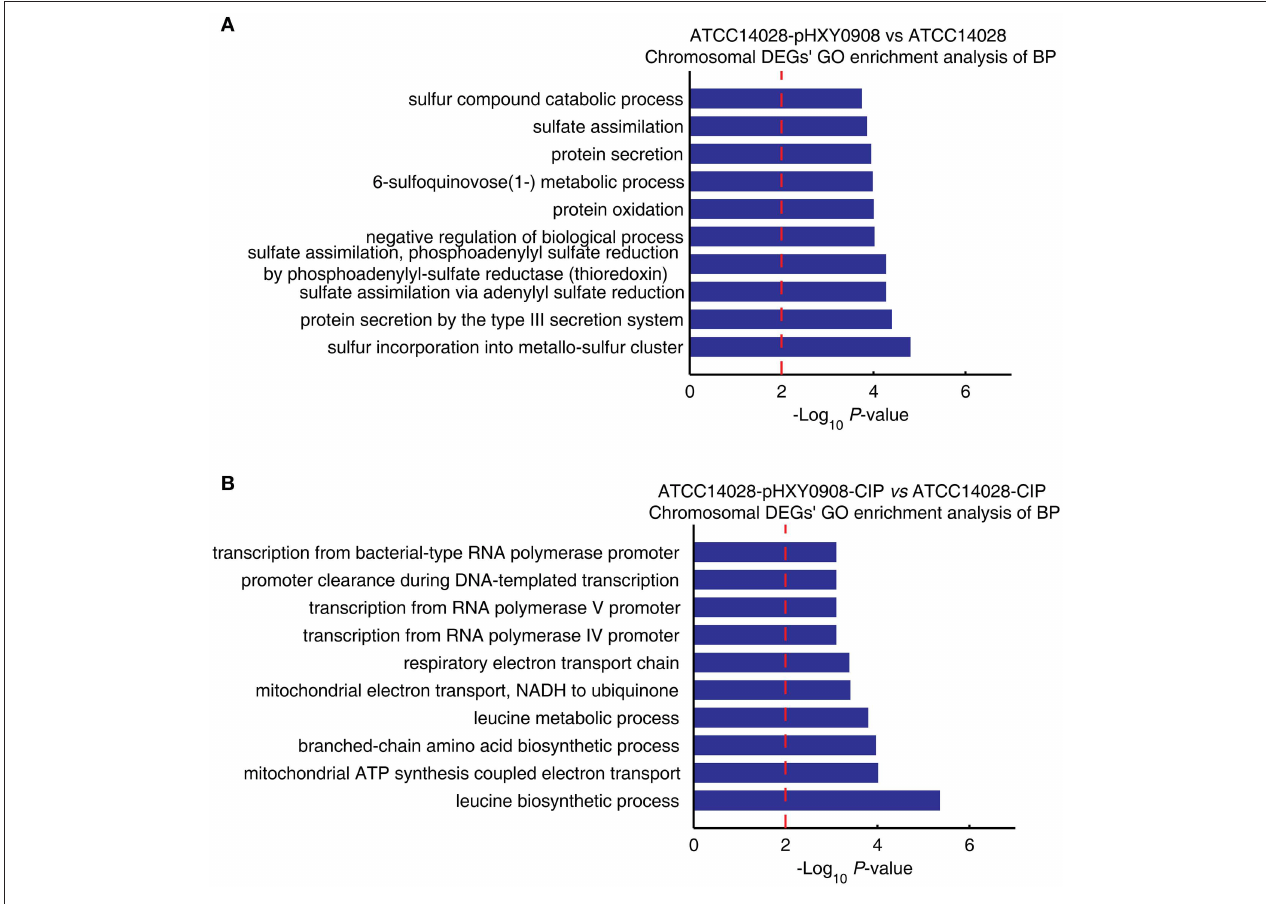
FIGURE 4 | The chromosomal DEGs GO enrichment analysis of biological processes. (A) ATCC14028-pHXY0908 vs. ATCC14028 and (B) ATCC14028-pHXY0908-CIP vs. ATCC14028-CIP (B) . The top 10 biological processes are shown. The dotted red line indicates the P -value threshold of